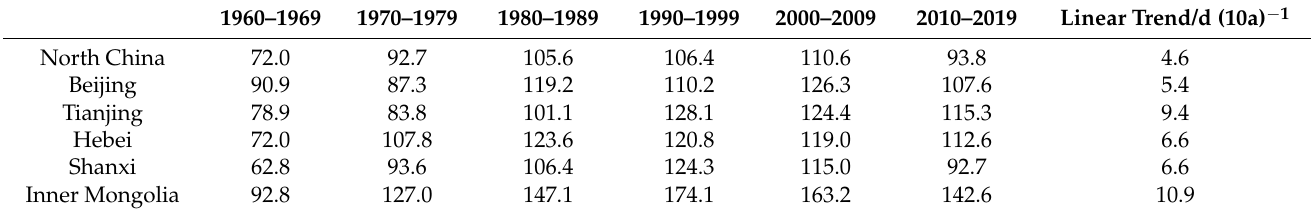
Table 2. Decadal average and linear trend rate of mild drought and above days for North China.